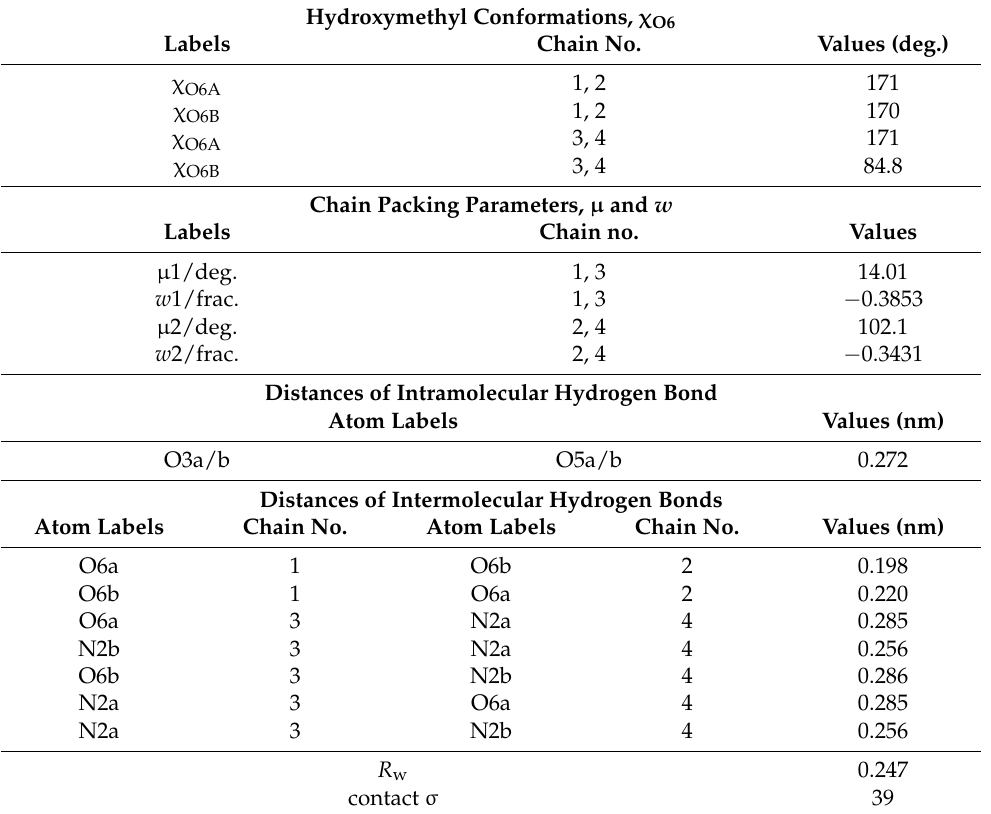
Table 5. Representative parameters of the final